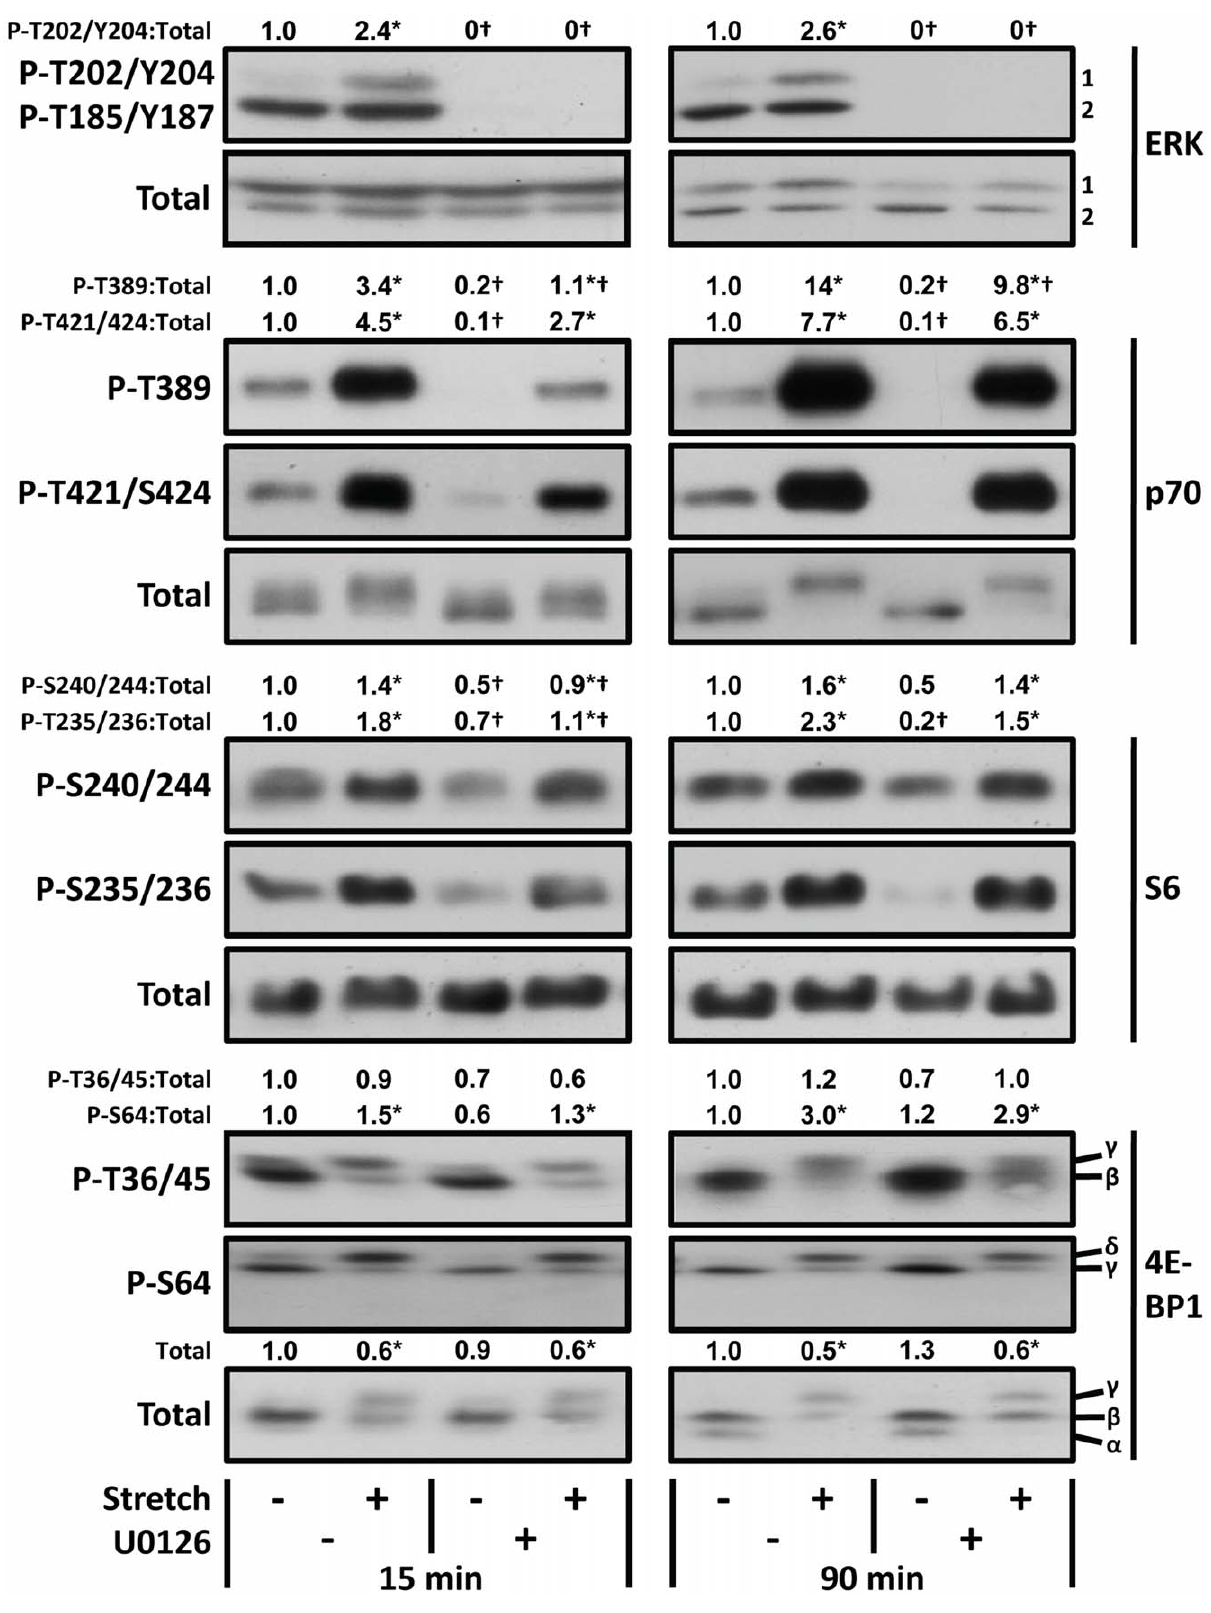
Figure 1. Mechanical stimulation activates mTOR signaling via an ERK-independent mechanism. EDL muscles were held at optimal length ( Lo ) in an ex-vivo organ culture system and pre-incubated with 50 m M U0126 (U0126 + ) or the vehicle (U0126 –, DMSO) for 30 min. The muscles were then subjected to 15 or 90 min of intermittent 15% stretch or held static at Lo as a control condition. Muscles were collected at the end of the